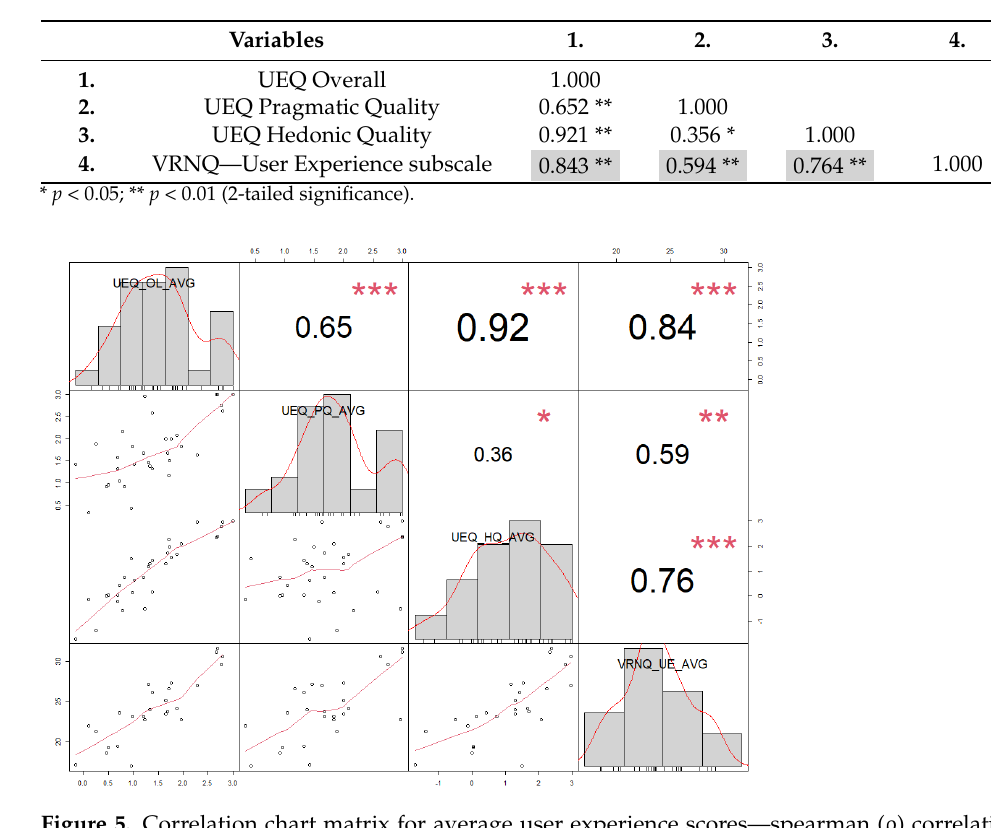
Table 20. Correlation matrix for average User Experience scores—Spearman ( ρ ) correlation coeffi-